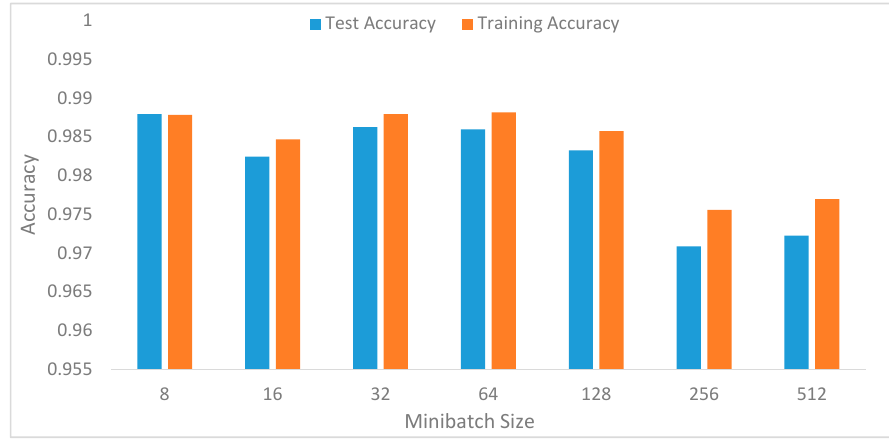
Figure 16. Recognition accuracy of the model with various batch sizes.